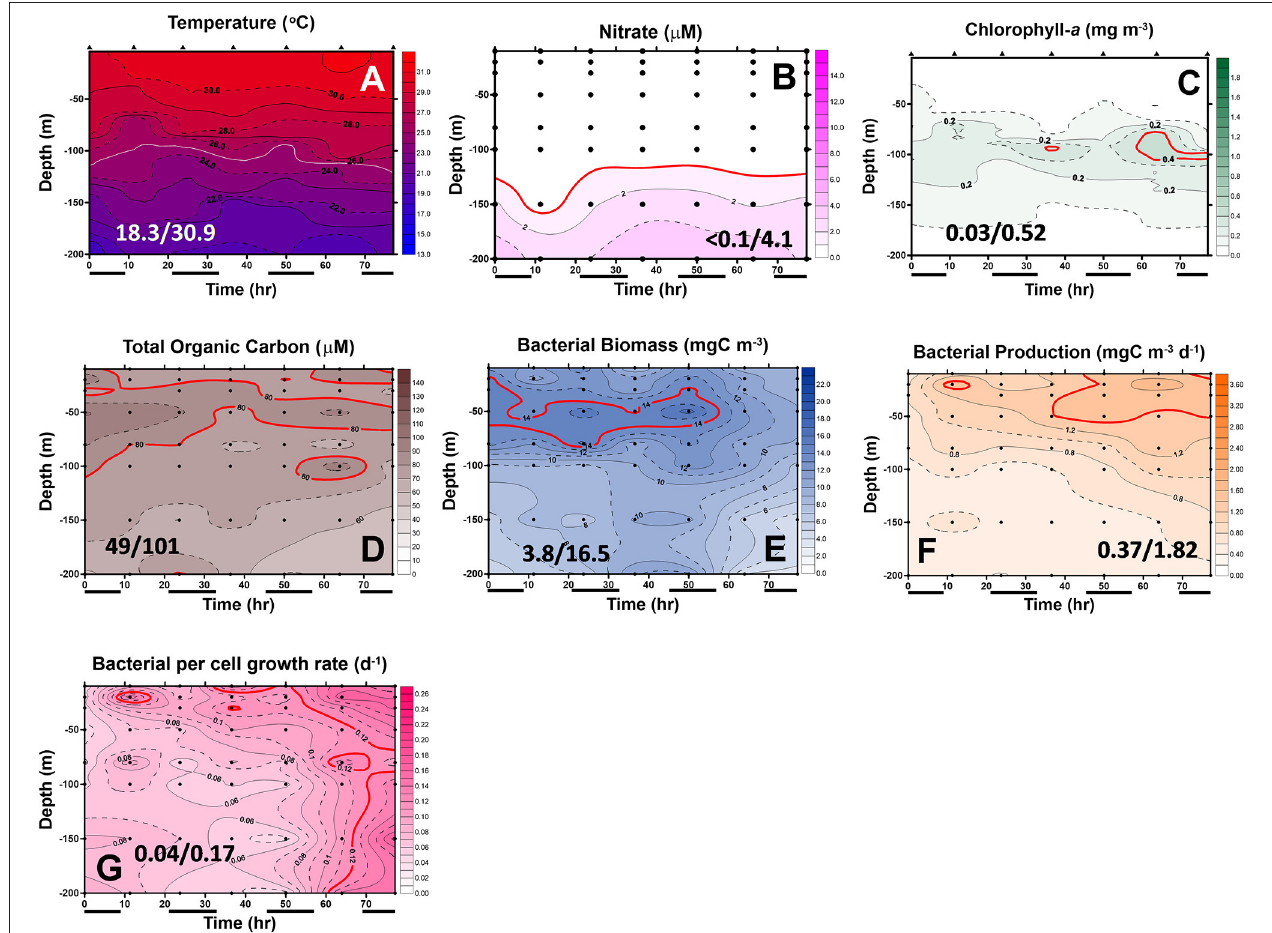
FIGURE 6 | Diel changes of the contour plots of the measurements in the upper 200m of station 6 of the July cruise. The values in slash indicate the minimum and maximum in each panel. The lines in (D–G) represent the isovalue lines of 80 µ MC total organic carbon (TOC), 14 mgC/m 3 BB, 1.4 mgC/m 3 /day bacterial production (BP), and 0.12 bacterial growth rate (B µ ) per day, respectively. The isovalue lines for (A – C) are the same as mentioned in Figure 5 . Black bars below the X -axis denote nighttime.